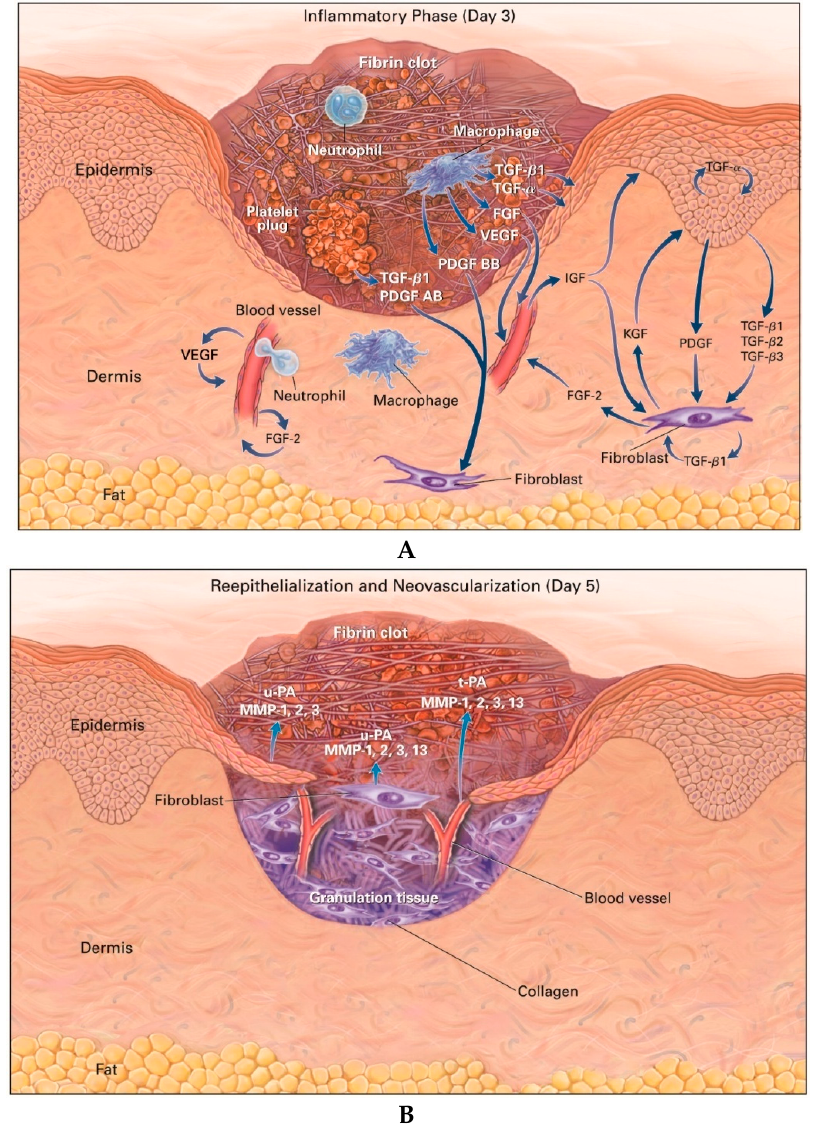
Figure 1. Cutaneous wounds 3 ( A ) and 5 days ( B ) after injury. Growth factors such as fibroblast growth factor (FGF), insulin-like growth factor (IGF), keratinocyte growth factor (KGF), platelet-derived growth factor (PDGF), transforming growth factor (TGF), and vascular endothelial growth factor (VEGF), and proteases such as matrix metalloproteinases (MMPs) and plasminogen activator (PA) are thought to be necessary for cell movement [reproduced with permission from Singer, A.J.; Clark, R.A. Cutaneous wound healing. N. Engl. J. Med. 1999 , 341, 738 ‒ 746].